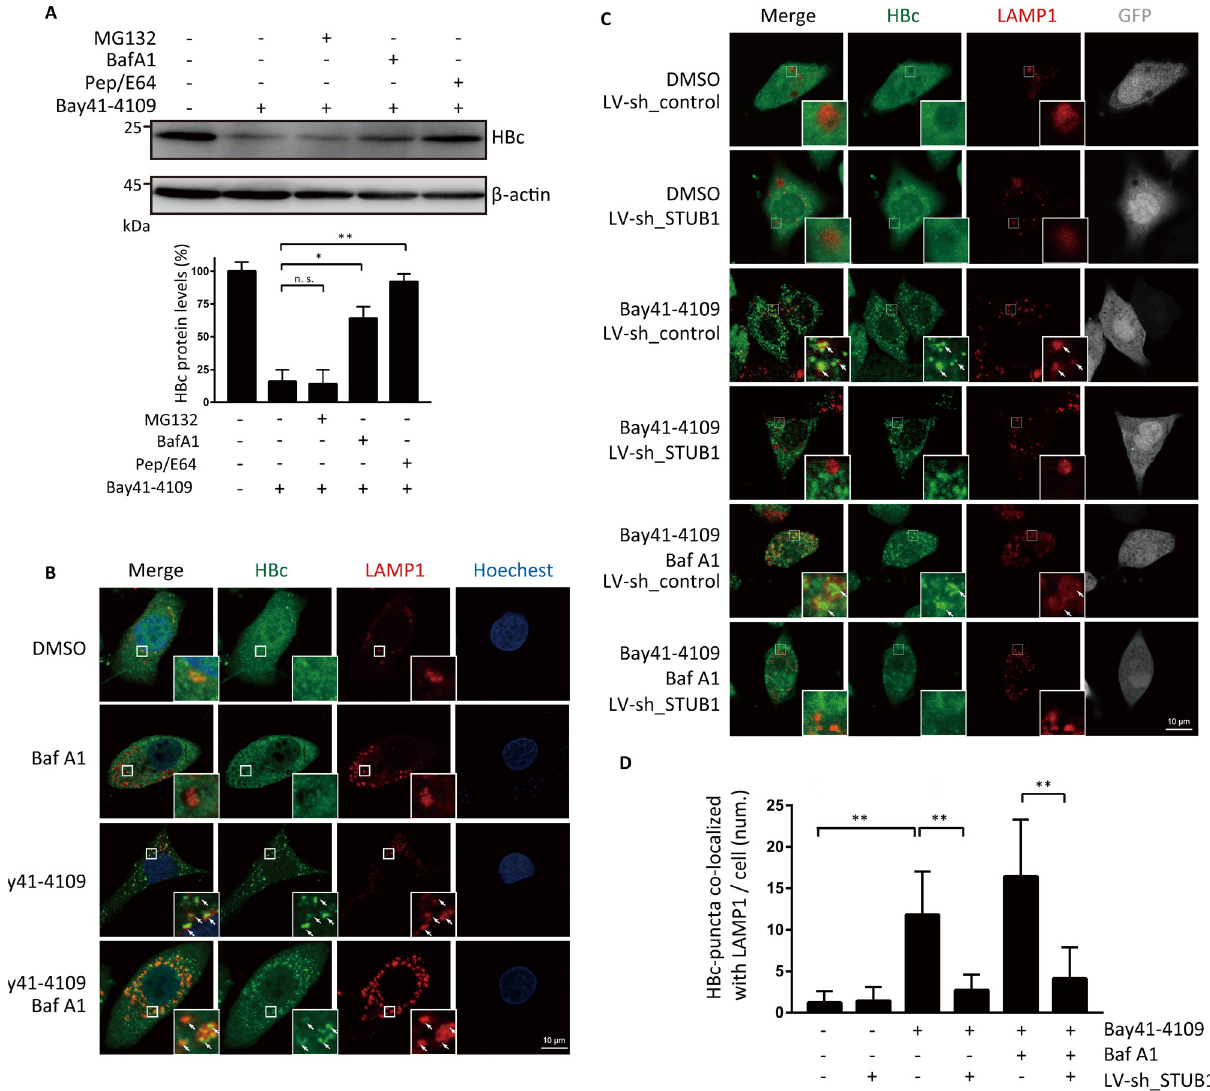
Fig 3. Bay41-4109 induces STUB1-driven lysosomal degradation of HBc. (A) HepAD38 cells were treated with 1 μ M Bay41-4109 or DMSO for 24 h, followed by treatment with 5 μ M of the proteasome inhibitor MG132, 0.1 mM of lysosome inhibitor BafA1, or 10 mM of lysosome inhibitor Pep/E64 for another 24 h. Cell extracts were then analyzed by western blotting using the indicated antibodies (upper panel). The quantification results of two independent immunoblots are shown as relative percentages (HBc/actin) with the DMSO-treated sample set to 100% (lower panel). The error bars indicate ± SD. �� p < 0.01, � p < 0.05, “n. s.” denotes p > 0.05. p values were calculated by unpaired two-tailed student’s t-test. (B) HepAD38 cells were treated with 1 μ M Bay41-4109 or DMSO as indicated for 24 h, followed by treatment with 0.1 mM BafA1 for 12 h. (C) HepAD38 cells transduced with LV-sh_STUB1 or control LV-sh_control were treated with 1 μ M Bay41-4109 or DMSO for 24 h. Subsequently, the cells were treated with 0.1 mM BafA1 for 12 h. GFP-positive cells indicate lentivirus transduction (gray). (C, D) The cells were immunostained for HBc (green) and LAMP1 (red). Areas indicated by white boxes are enlarged. Arrows point to typical co-localized sites. Scale bar is 10 μ m. (D) Quantification of the number of HBc puncta co- localized with Lamp1 per cell. 100 cells were counted. The error bars indicate ± SD. �� p < 0.01, “n. s.” represents p > 0.05, p values were calculated by unpaired two-tailed student’s